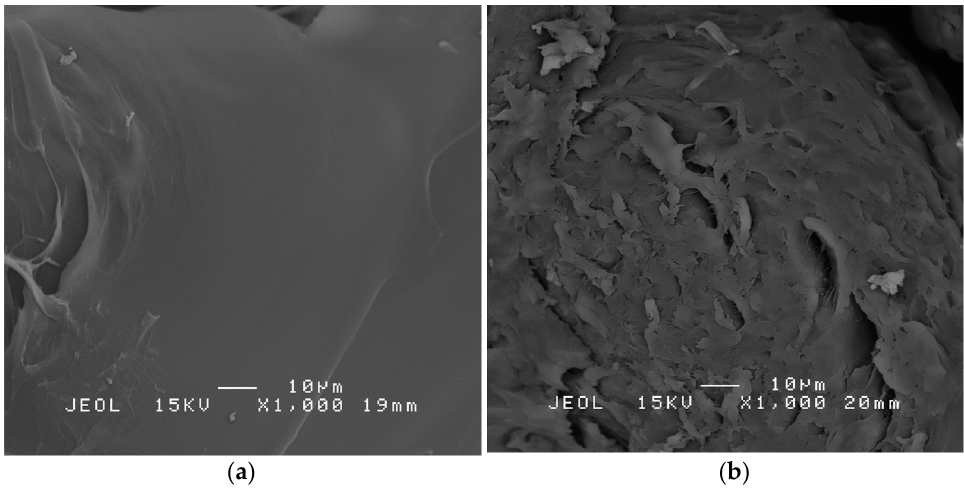
Figure 6. Scanning electron microscope (SEM) images of ( a ) untreated and ( b ) treated PS microplastics. The samples were viewed under SEM (JSM 6400 SEM, JEOL Ltd., Tokyo, Japan) with 1000× magnification.